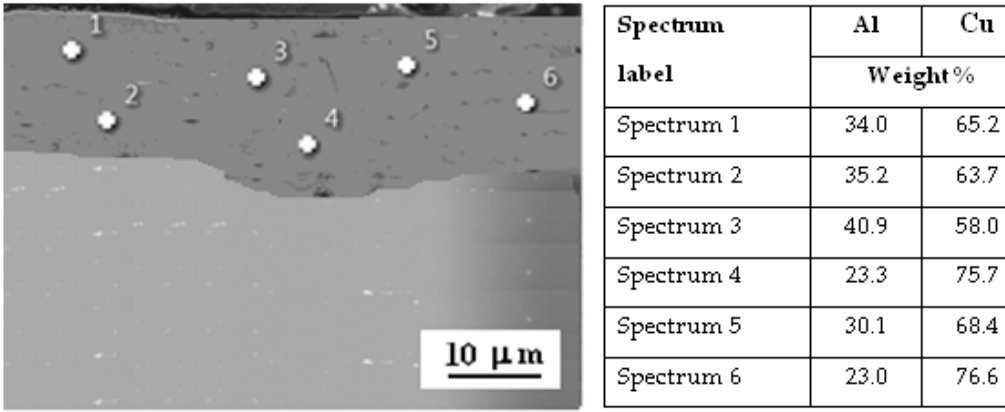
Figure 4. Scanning electron microscopy (SEM) micrograph and energy-dispersive spectroscopy (EDS) for Al/Cu alloy and the results of point X-ray microanalysis of the chemical composition of the tested alloy.